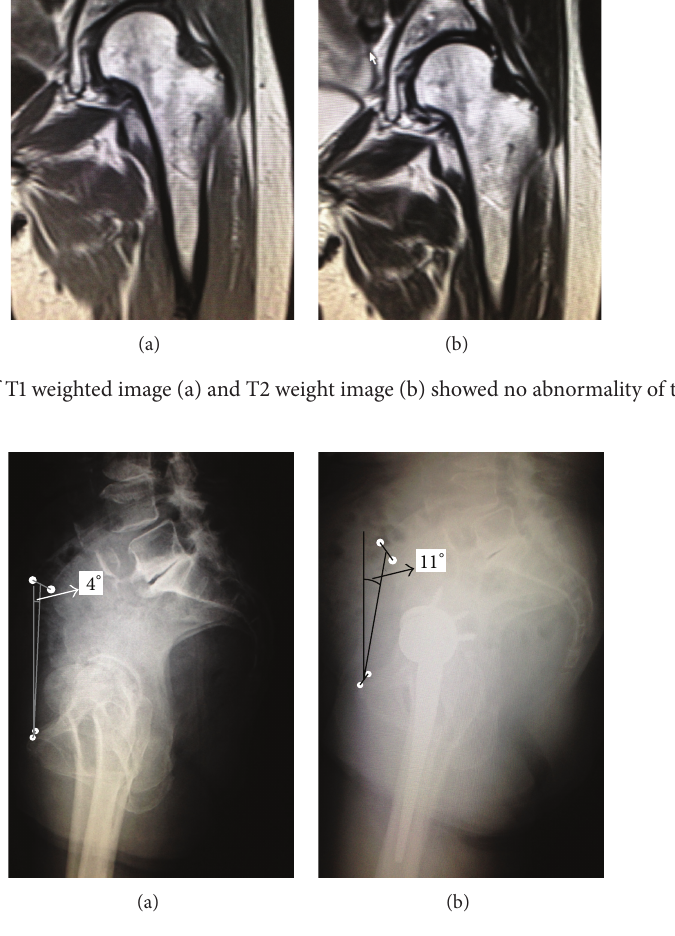
Figure 4: Alignment change assessment using the standing lateral X-ray. The pelvic tilt was defined as the angle between the vertical line and the anterior pelvic plain, which was constructed by the line passing through the midpoint of the bilateral anterior iliac spines and the midpoint of the bilateral pubic tubercles. At the time of right THA (a), the pelvic tilt angle was 4 ∘ . At the time of left THA, the pelvic tilt angle was 11 ∘ . The pelvic was tilted posteriorly about 6 ∘